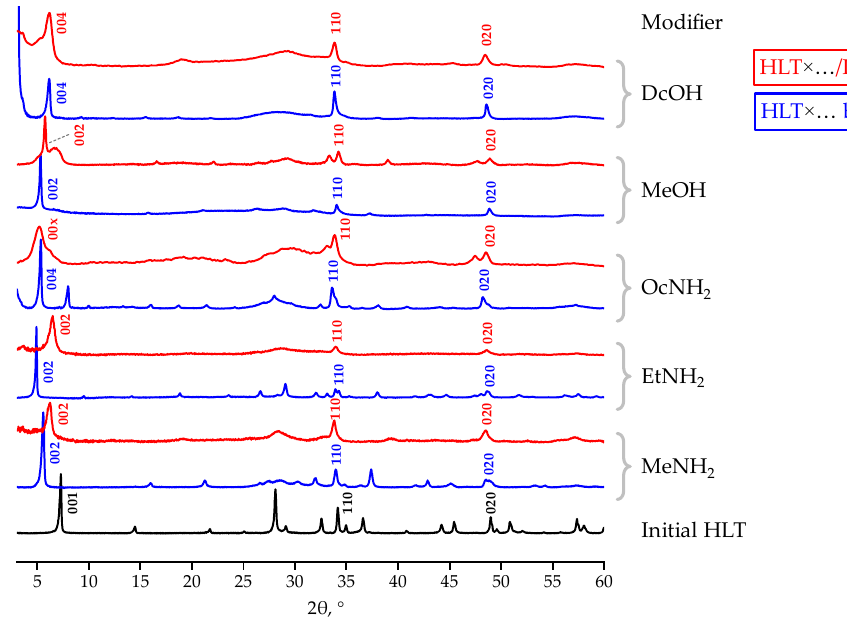
Figure 5. XRD patterns of some inorganic–organic derivatives before and after photocatalytic (PC) experiments.